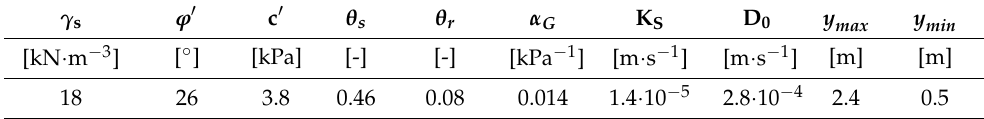
Table 2. Geotechnical and hydraulic properties for the study area